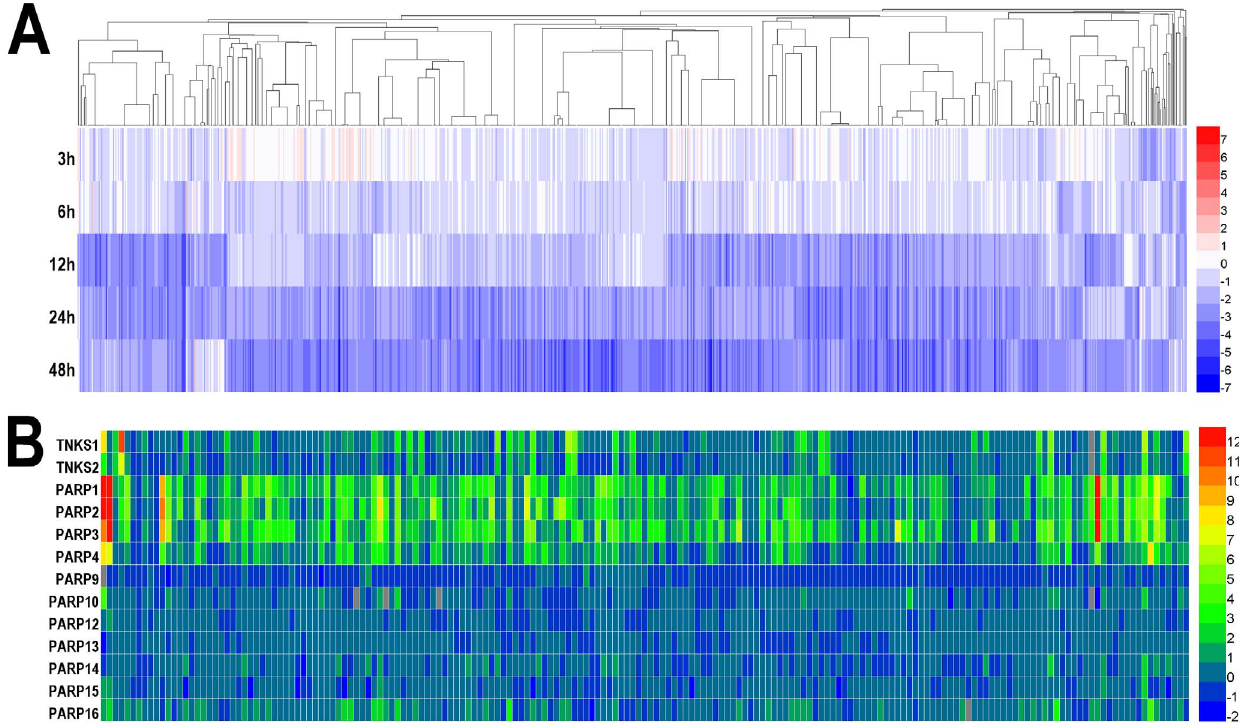
Figure 2. Illustrating heatmaps by HemI 1.0. (A) Thermal shifts, which indicate binding affinities of 185 compounds to 13 PARPs, were measured by DSF. A higher value represents a stronger binding affinity. (B) Totally, 428 androgen-repressed genes were identified from LNCaP cells, after the treatment of 1 nM synthetic androgen R1881 for 3, 6, 12, 24 and 48 hours. Values shown were normalized to 0 hour and log 2 transformed. doi:10.1371/journal.pone.0111988.g002 PLOS ONE |